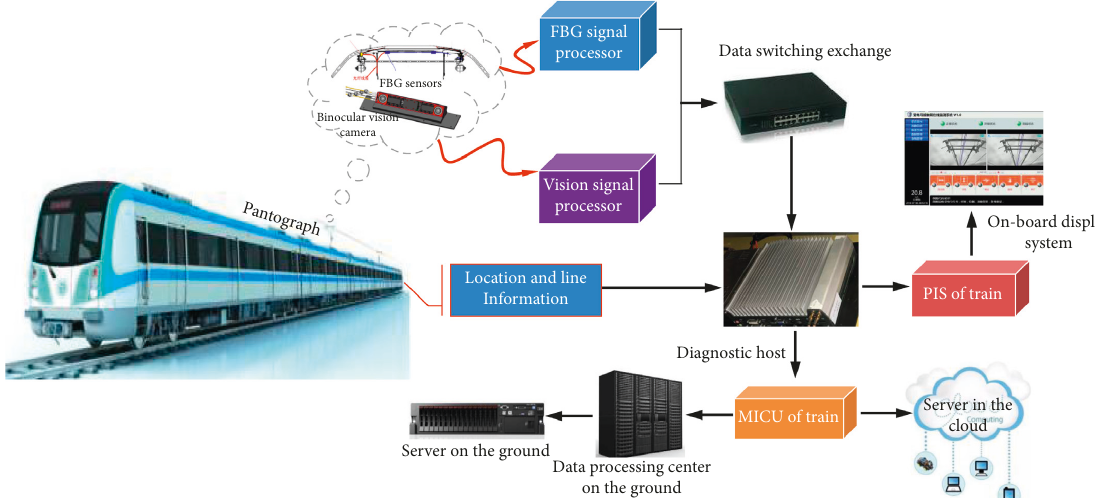
Figure 1: Architecture of the pantograph monitoring system.